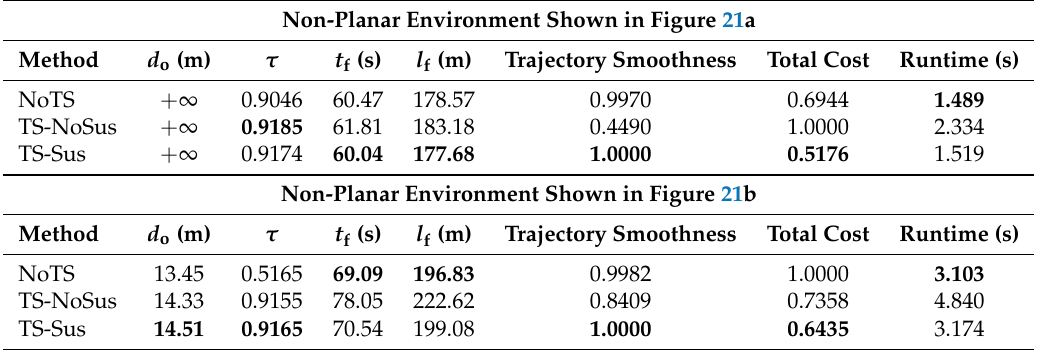
Figure 22. The z -coordinate, the roll, and the pitch of the vehicle along the paths and the trajectories. ( a – c ) The vehicle state along the trajectories shown in Figure 21a; ( d – f ) The vehicle state along the trajectories shown in Figure 21b. Table 8. The performance comparison of the trajectories shown in Figure 21 (averaged over 50